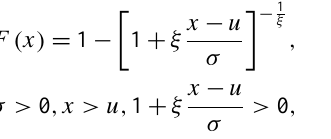
column ozone over the USA. To this aim we use a set